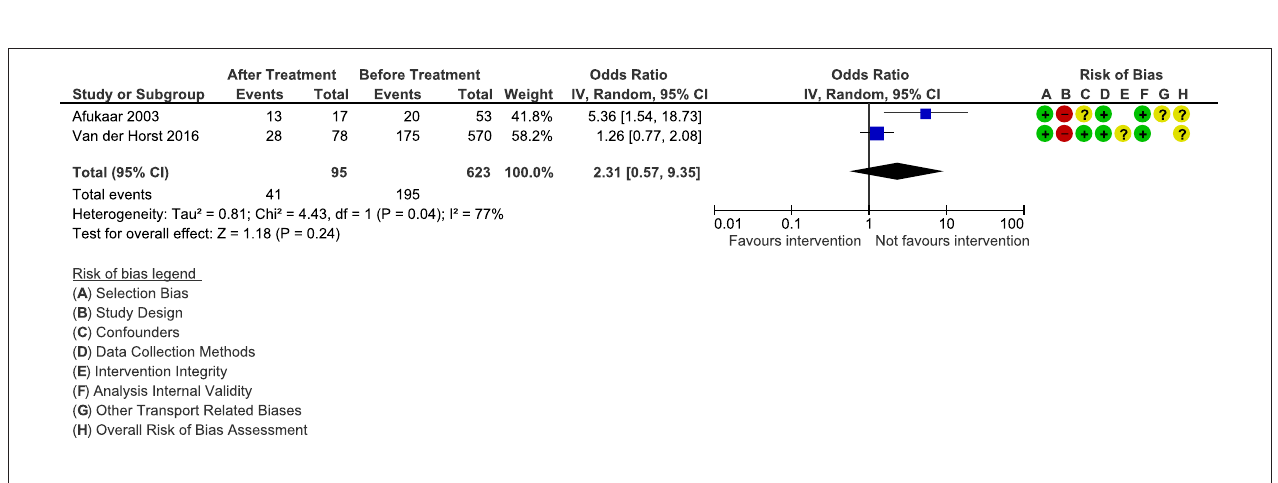
FIGURE 4 | Primary outcome: changes in the number of ‘road accident casualty’ after road engineering interventions.